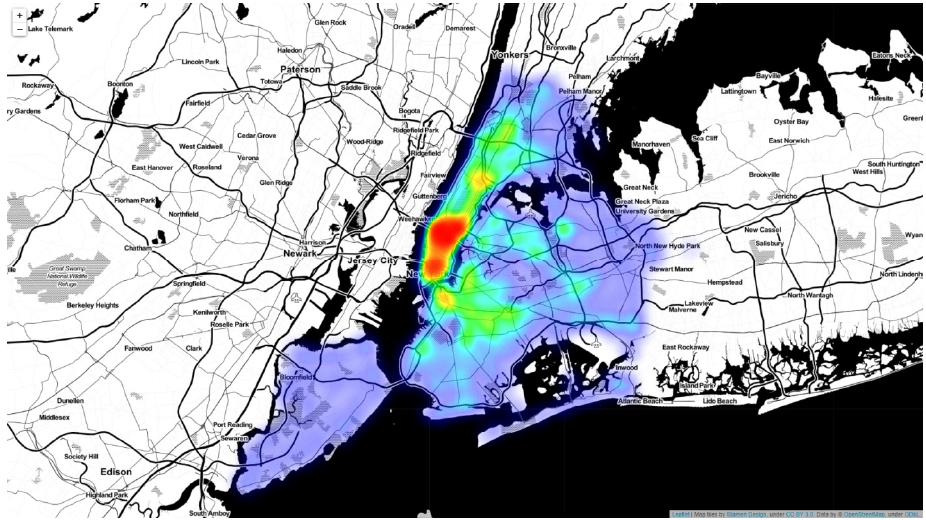
Figure 13. General view of the city and the MVTC heatmap overlay. Figure 14 shows a zoomed-in MVTC heatmap. Figure 15 demonstrates a zoomed-in heatmap of traffic collisions in the western part of the city.